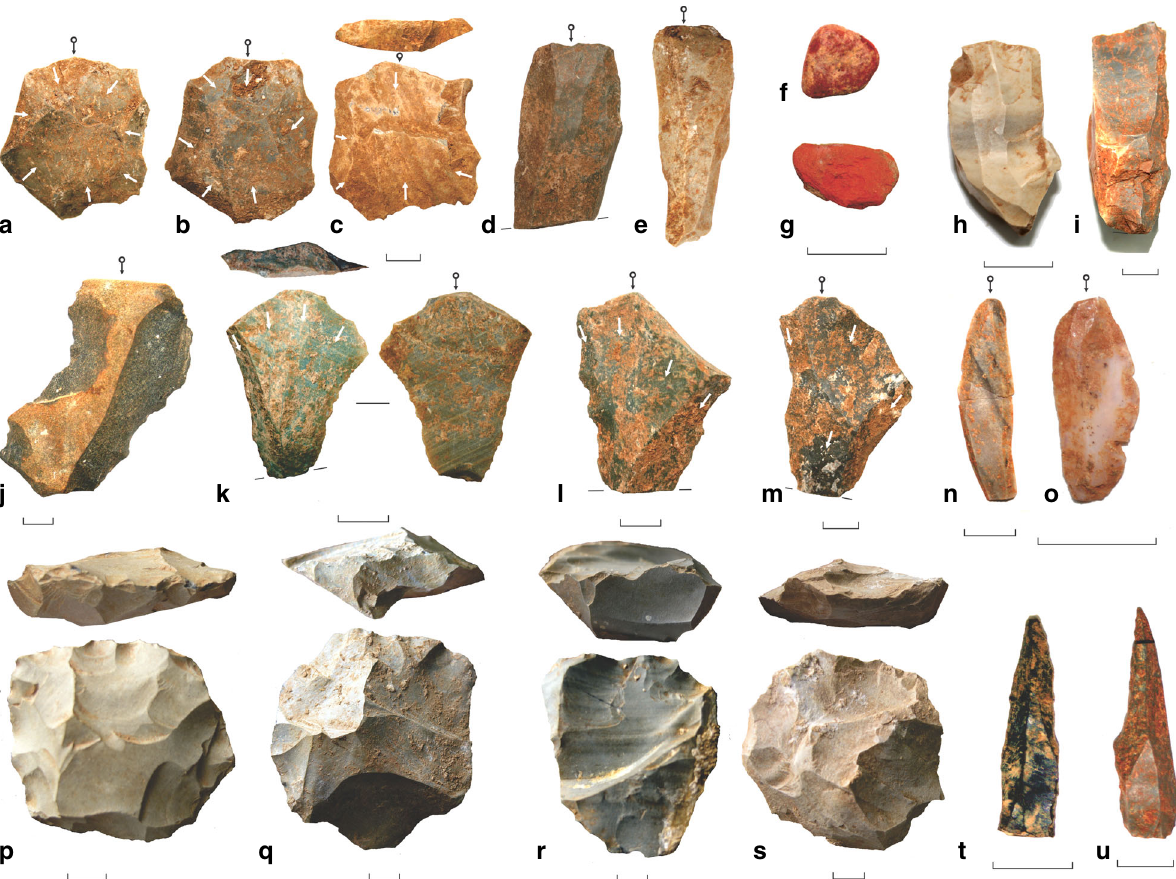
Fig. 4 Key artefact types at Dhaba from 80 to 25 ka. a – c Levallois fl akes, Dhaba 1 and 2. d , e Levallois blades, Dhaba 1. f , g Ochre, Dhaba 1. h , i Microblade cores, Dhaba 3. j Notched scraper, Dhaba 1. k – m Levallois points, Dhaba 1 and 2. n , o Agate and chert microblades, Dhaba 3. p – s Recurrent Levallois cores, Dhaba 1 – 3. t , u Backed microliths, Dhaba 3. White arrows indicate scar directions. Black arrows with circles indicate impact